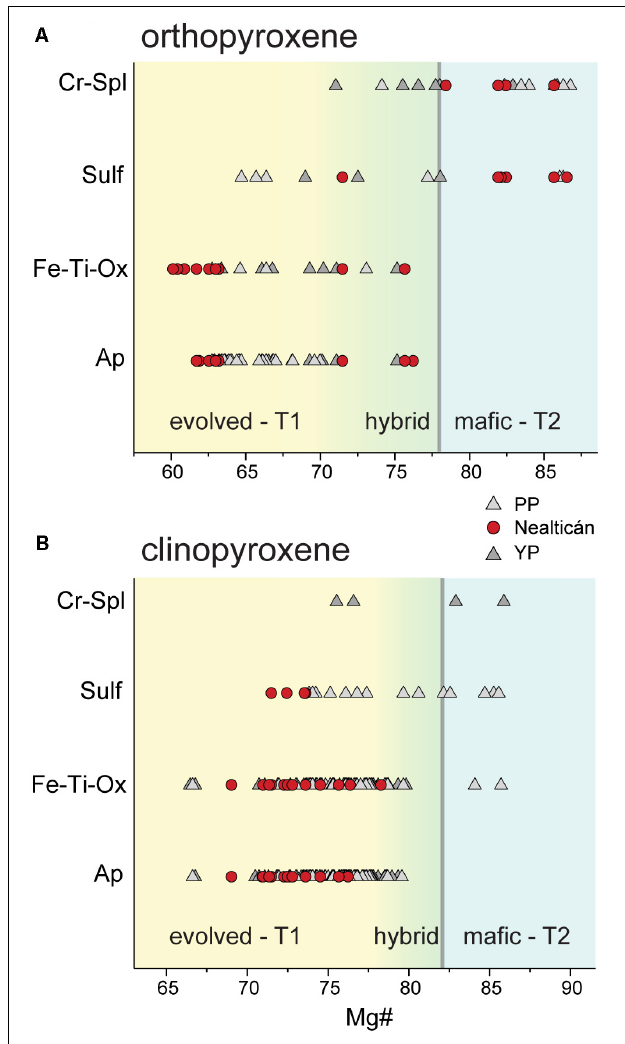
FIGURE 8 | Presence of mineral inclusions in (A) orthopyroxene and (B) clinopyroxene with respect to their host pyroxene compositions, compiled for the Yellow Pumice Plinian eruption (YP), the Nealticán flank eruption, and the Pink Pumice Plinian eruption (PP). See text for